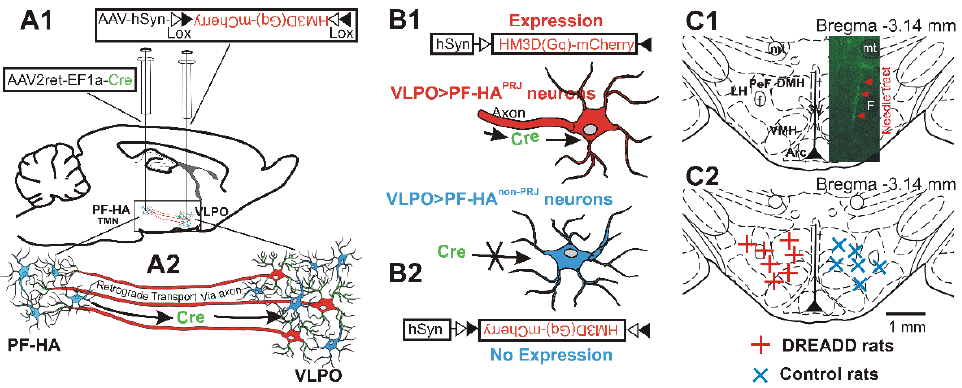
Figure 1. Schematic of the procedure used for the chemoactivation of VLPO > PF-HA PRJ neurons . ( A1 , A2 ): schematic representation of viral vector injections, AAV2retro-EF1a-Cre in the PF-HA, and AAV-hSyn-DIO-hM3D(Gq) in the VLPO, and the retrograde transport of Cre-recombinase into the subset of VLPO neurons projecting to the PF-HA ( A2 ). ( B1 , B2 ): Cre-dependent expression of hM3Dq-mCherry in VLPO > PF-HA PRJ neurons ( B1 ) and not in the VLPO neurons not projecting to the PF-LH (VLPO > PF-HA non-PRJ ) neurons ( B2 ). This approach was used to specially target and examine the role of VLPO > PF-HA PRJ neurons and their interactions with the PF-HA neuronal groups in sleep – wake regulation. ( C1 , C2 ): AAV2retro-EF1a-Cre injection sites in the PF-HA. Although the AP locations of the injection sites varied by 100 – 200 µm, these are shown in one plane (Bregma − 3.14 mm; adapted with permission from Paxinos and Watson, 1998 [32]). ( C1 ): photomicrograph of a representative histological section showing the needle tract, as indicated by the increased autofluorescence, which was used to identify injection sites in the PF-HA. ( C2 ): The locations of all injections in the DREADD and non-DREADD control groups. The locations of injection sites were broadly comparable in both the DREADD and control groups. Thus, it is likely that similar groups of VLPO > PF-HA PRJ neurons were retrogradely labeled in both DREADD and control groups. 3V, third ventricle; Arc, arcuate nucleus; DMH, dorsomedial hypothalamus; f, fornix; LH, lateral hypothalamus; mt, mammillothalamic tract; PeF, perifornical nucleus; TMN, tuberomammillary nucleus; VLPO, ventrolateral preoptic area; VMH, ventromedial hypothalamus.